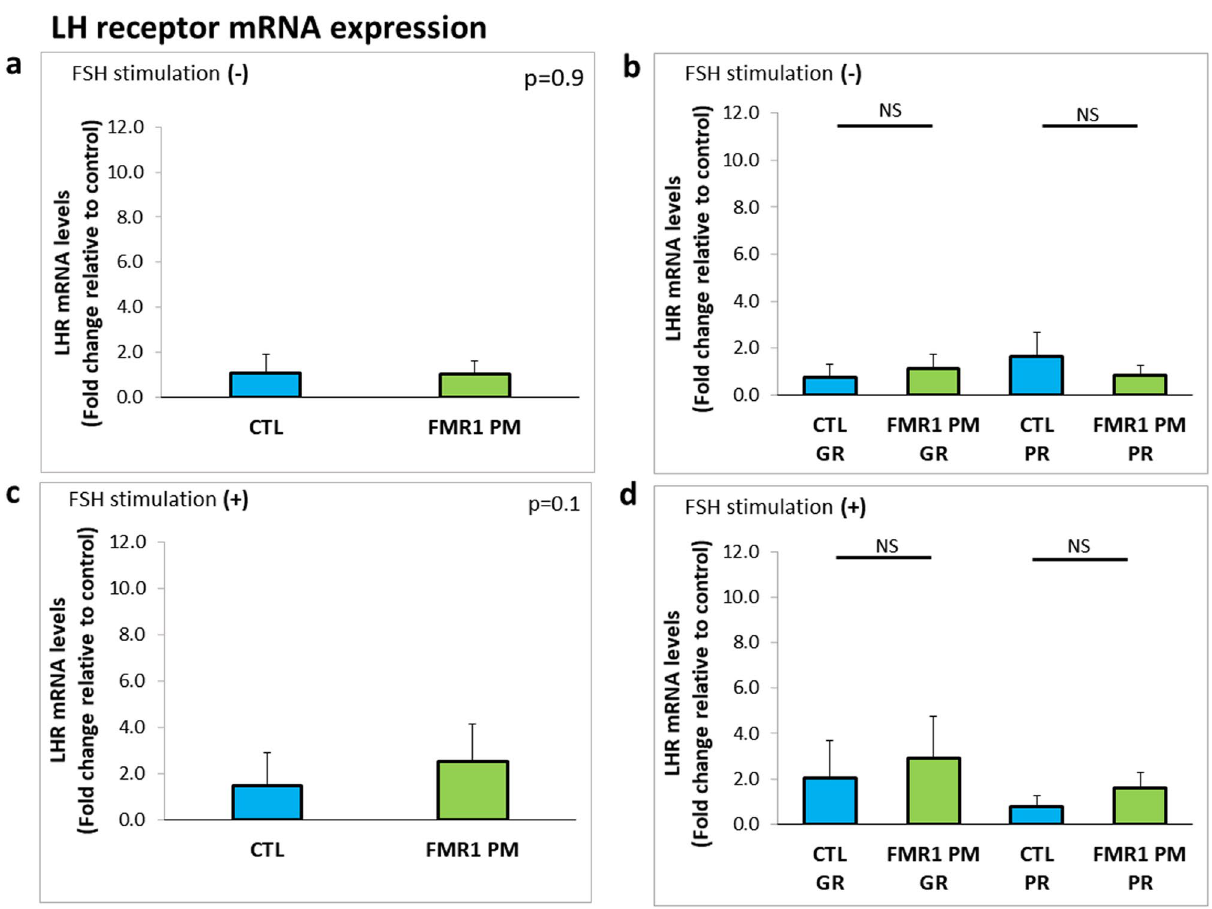
Figure 4. Similar LHR mRNA expression levels in MGCs of FMR1 premutation carriers and noncarriers. ( a ) Expression levels in MGCs of FMR1 premutation carriers ( FMR PM) and non-carriers (CTL) without FSH stimulation. ( b ) Expression levels in MGCs by number of oocytes retrieved in OPU: GR > 5, PR ≤ 5. ( c ) Expression levels in MGCs following 48 h of FSH stimulation. ( d ) Expression levels in FSH-stimulated MGCs by number of oocytes retrieved in OPU: GR > 5, PR ≤ 5. Graphs show fold change relative to control expression ±